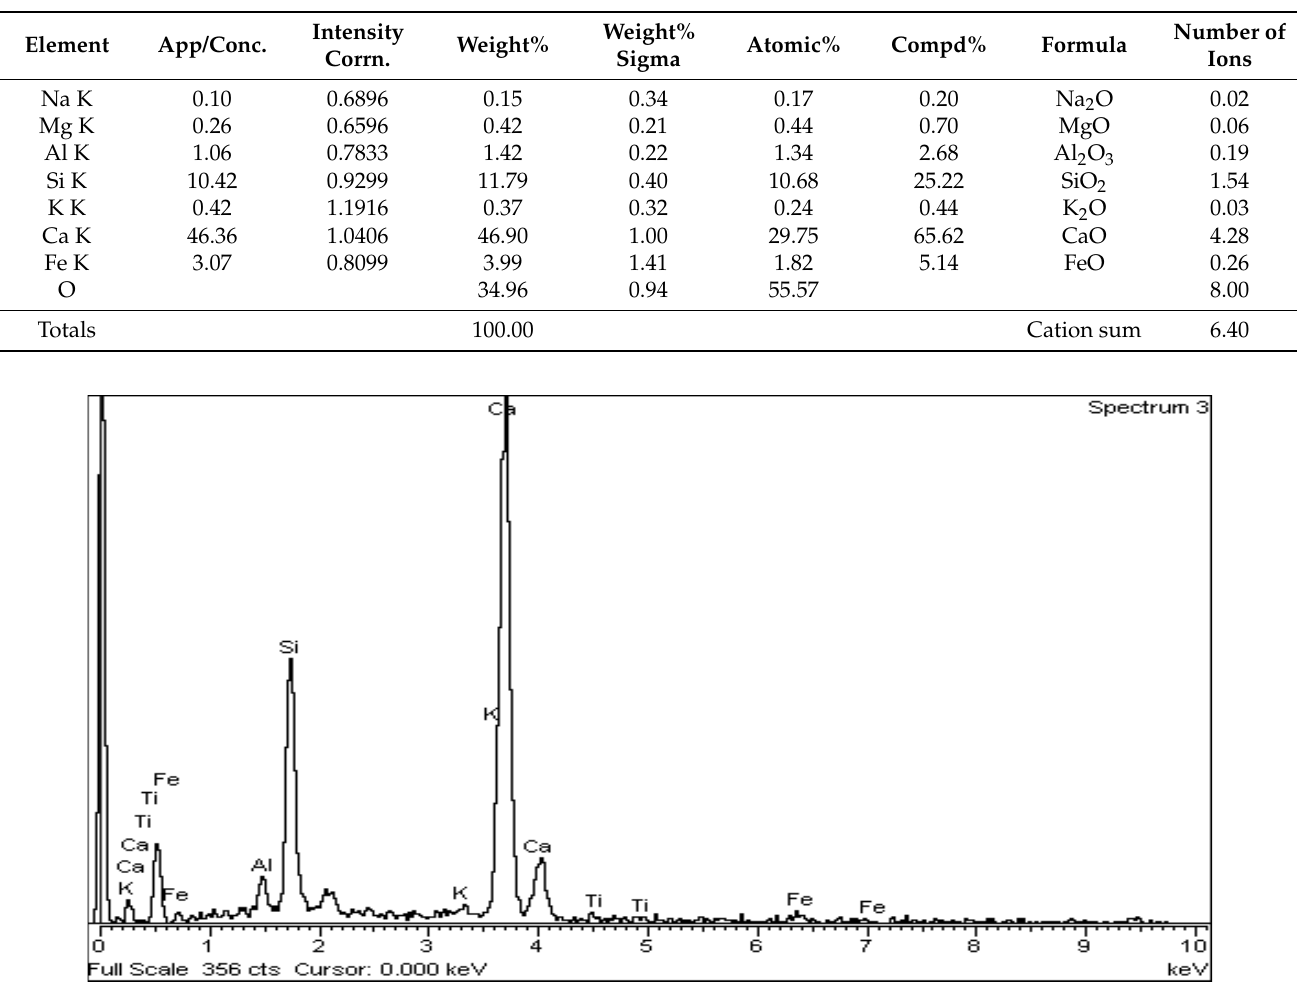
Table 9. EDS analysis for alite crystal of point “ Spectrum 2 ” of Figure 15.